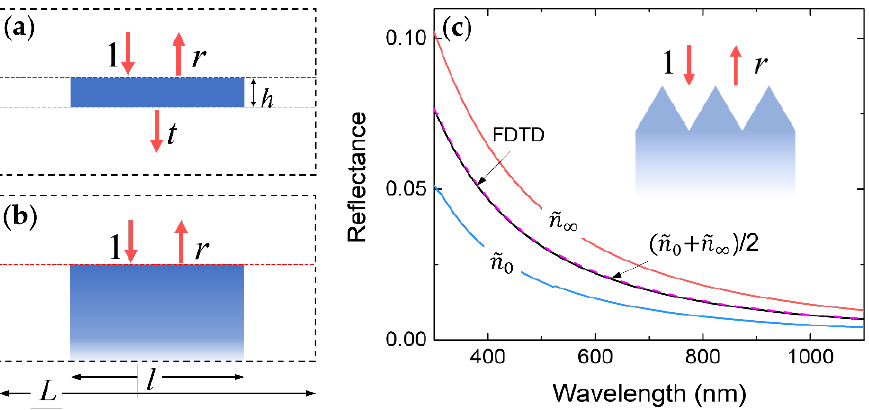
Figure 2. ( a ) The FDTD computational cell for obtaining the exact effective index 𝑛̃ 0 of a thin square disk suspended in air. ( b ) The cell for obtaining the exact effective index 𝑛̃ ∞ of a semi-infinite square rod. ( c ) The reflectance of an array of square-based pyramids of SiO 2 on top of a semi-infinite substrate of the same material (see inset). The FDTD result is compared to the effective index model of the multi-sliced system using the 𝑛̃ 0 , the 𝑛̃ ∞ , and the average effective indices. In case (a), each slice j (starting from the bottom) of the pyramid is treated as a square area of thickness h and side length l j embedded in air, where j = 1, 2, . . . N is the